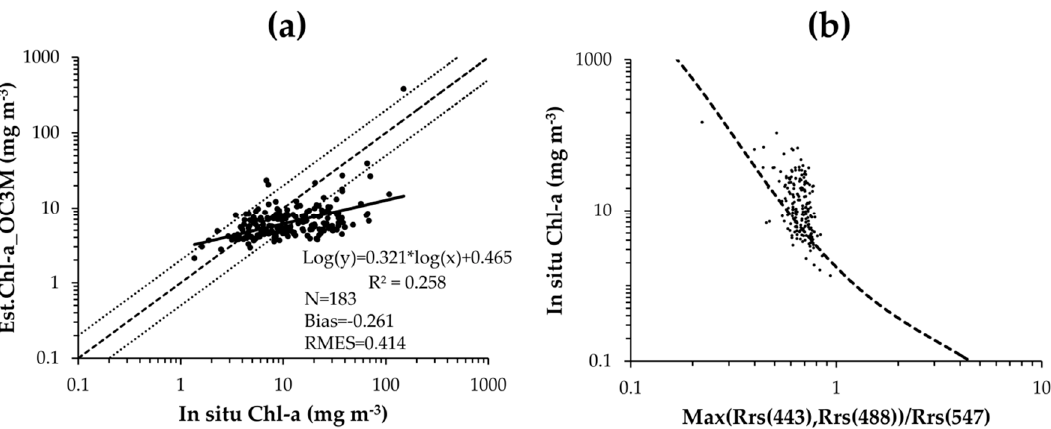
Figure 6. ( a ) Comparison of in situ and OC3M estimated Chl-a. ( b ) Relation between in situ Chl-a and max(Rrs443, Rrs488)/Rrs547 (R). Data are from Nagoya and Nagasaki universities datasets. The dash and dotted lines in ( a ) are Y = X, Y = 2X/Y, and Y = X/2, respectively. The dashed line in ( b ) is the OC3M algorithm. Table 2. Statistics of Chl-a, total suspended matter (TSM), colored dissolved organic matter (CDOM), and proportions of a ph (443), a npp (443), and a y (443) of the total of absorptions. Parameters